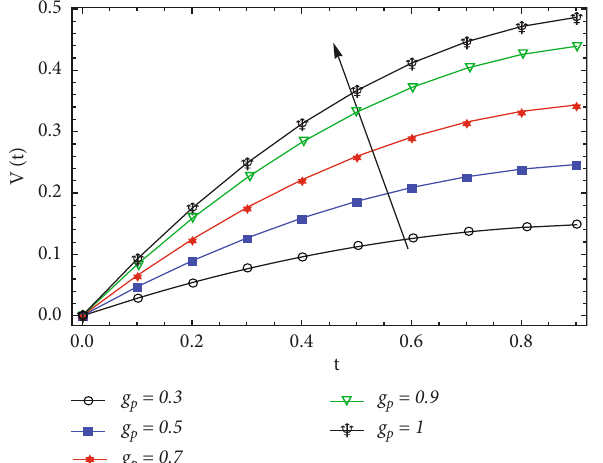
Figure 6: In drainage case e ff ect of g and β = 1 are fi xed.